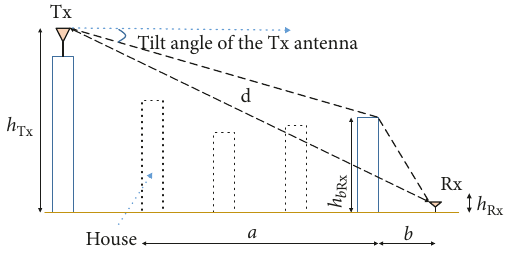
Figure 2: Side view of the house geometry and